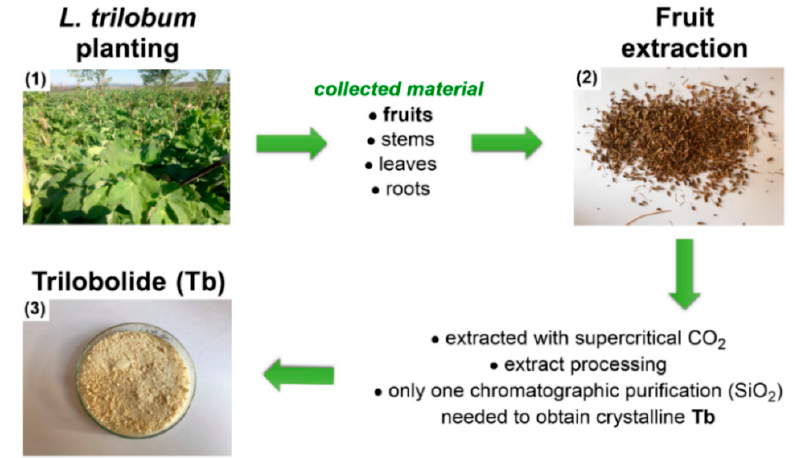
Figure 2. Optimized route for large scale Tb isolation, i.e., ( 1 ) cultivation of L. trilobum and plant harvesting, and ( 2 ) drying of fruits and gram-scale isolation of Tb ( 3 ).